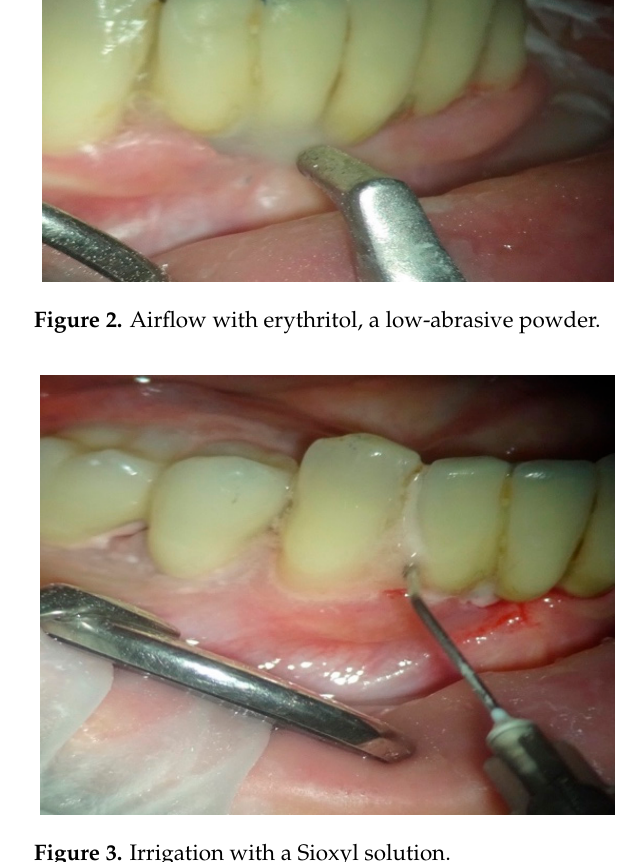
Figure 4. Treatment with a Wiser diode laser with a peak power of 2.5 W, T-On of 20 microns, T- Off of 80 microns, average power of 0.5 W, duty cycle of 100 microns and frequency of 10 KHz. In the control group C, first, microbiological sampling (T1) of the periodontal pockets was conducted. Then, a supragingival scaling with high-frequency ultrasounds and a sub- gingival scaling and root planning in all periodontal pockets with high-frequency ultra- sounds and Gracey’s curettes were performed. The third session (T2) was conducted 7 days after the second session. In group A, which was treated with the LANAP protocol, the second microbiological sampling (T2) of the periodontal pockets was performed upon rinsing with gauze soaked in chlorhexidine. In group B, which was treated with the OHLLT protocol, the second microbiological sampling (T2) of the periodontal pockets was performed. After that, a new diode laser treatment + Sioxil ® , as in the second session, was conducted upon irrigating the periodon- tal pockets with the Sioxil ® solution (Figure 3), leaving the solution for at least 2 min and irradiating with a Wiser diode laser with a peak power of 2.5 W, T-On of 20 microns, T- Off of 80 microns, average power of 0.5 W, duty cycle of 100 microns and frequency of 10 KHz. In the control group C, the second microbiological sampling of the periodontal pock- ets was performed. The fourth session (T3) was conducted 9 months after the second ses- sion. 2.4. Statistical Analysis